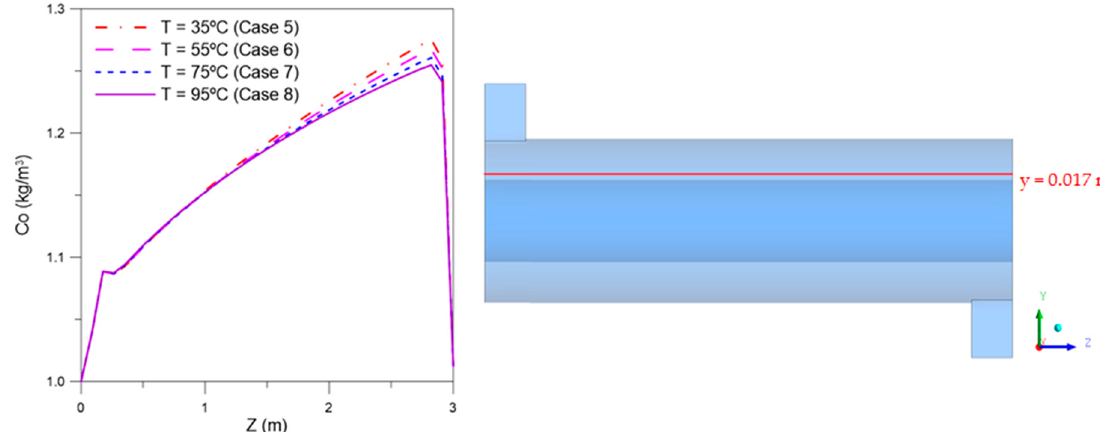
Figure 17. Oil concentration profile along the z-axis, at y = 0.017 m (Cases 5–8).